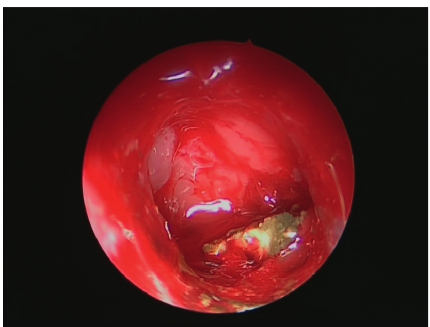
Figure 6: Intraoperative endoscopic view showing left sphenoid sinus fungal ball.